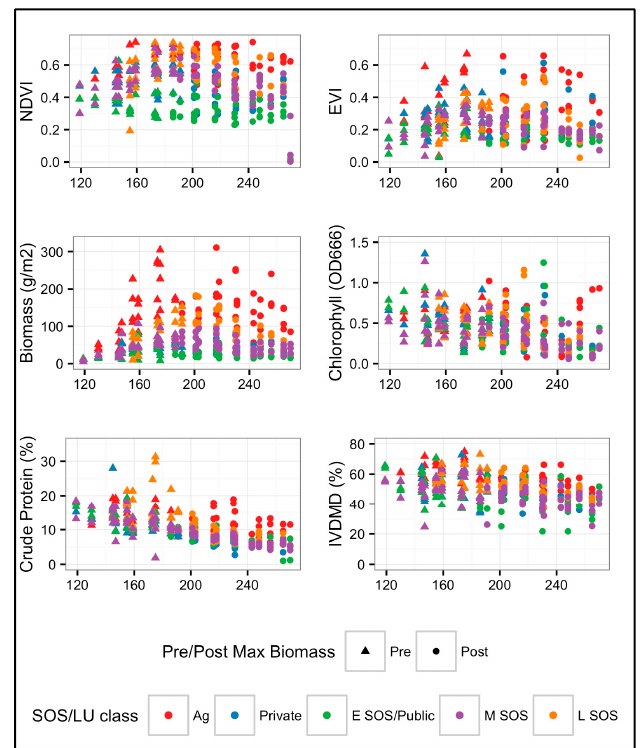
Figure 3. Seasonal variation in NDVI, EVI, biomass, chlorophyll, crude protein, and IVDMD in grasslands in the different start of season and land use classes in the Upper Yellowstone River Basin. Shapes represent estimates from before/after the peak in biomass.